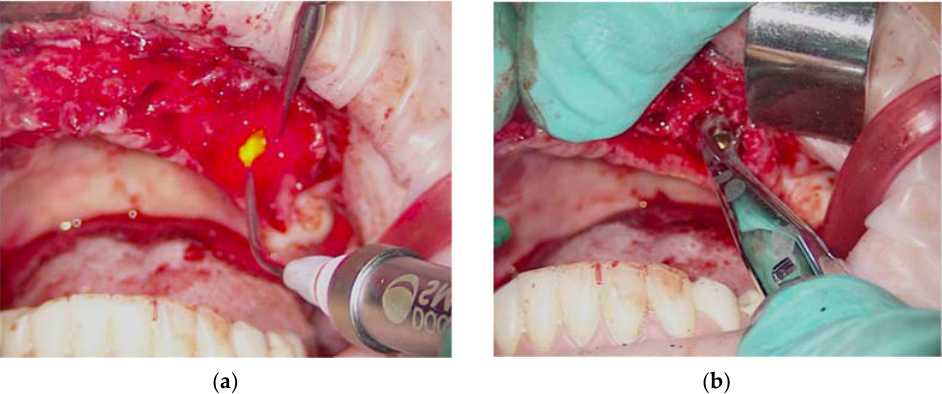
Figure 5. Oxygen high level laser therapy, OHLLT ( a ); measurement of the post ‐ extraction site ( b ).